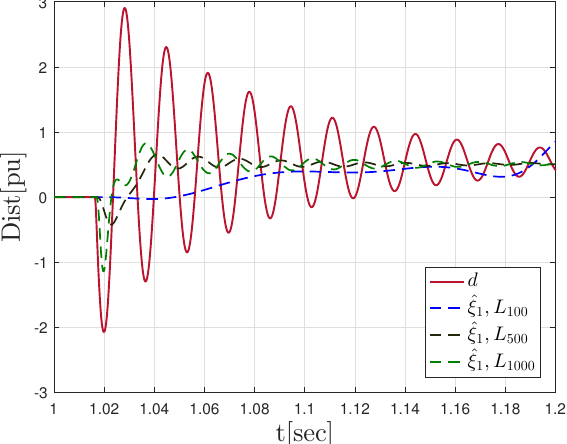
Figure 8. Fixed-gain IMDOB